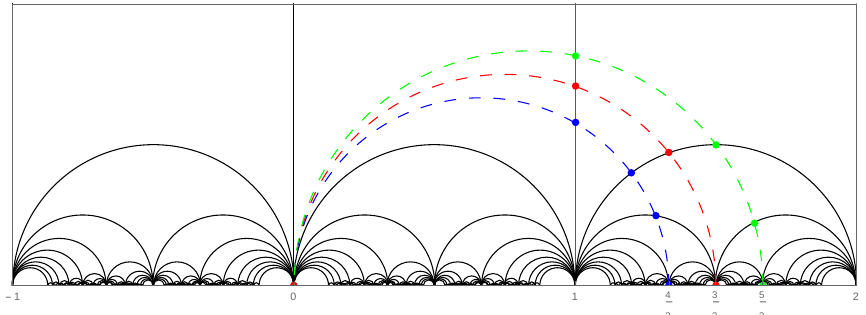
Figure 8. Geometric view of the sum of continued fraction coe(cid:14)cients contributing to (3.10) in the Farey tesselation of the hyperbolic plane (denoted by the black solid curves). P the \geodesic distance" between the origin (the unknot) and the fraction n the number of edges connecting them along a semicircular geodesic path that goes through the tiles. This is illustrated for K 3 ; 2 ; K 4 ; 3 , and K 5 ; 3 by the dashed red, blue, and green curves, respectively, which have d 3 ; 2 = 3 and d 4 ; 3 = d 5 ; 3 = 4.